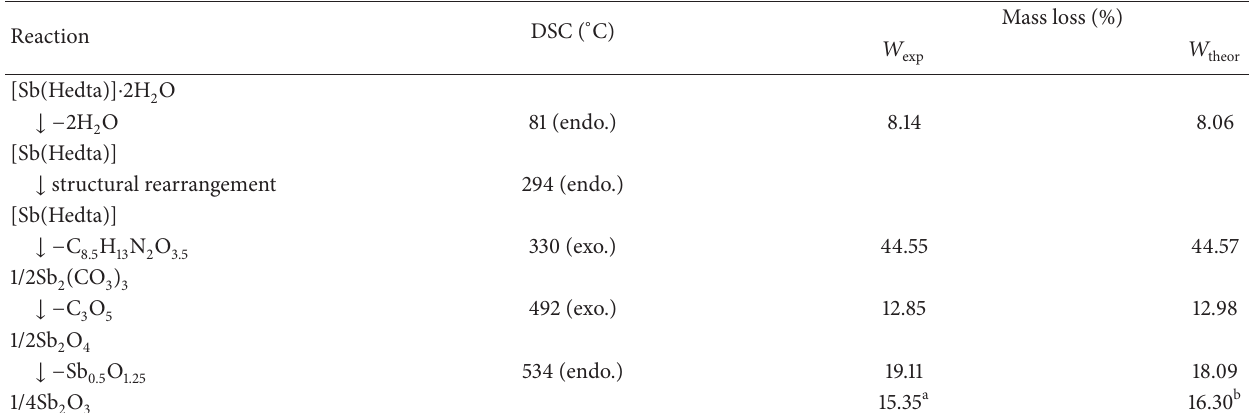
Table 5: Thermal decomposition data of the title